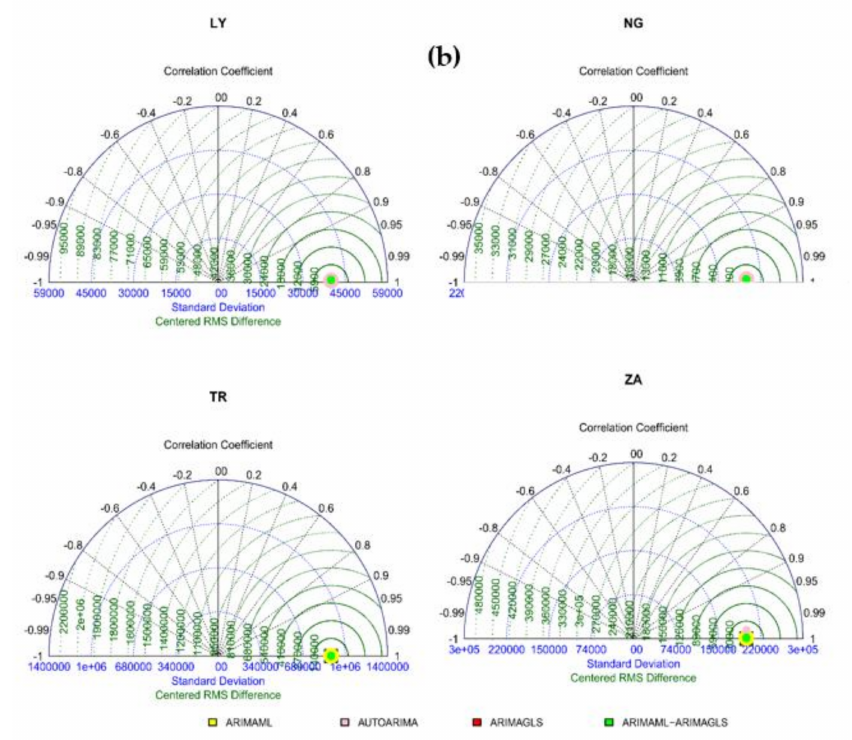
Figure 12. Taylor diagram for the: ( a ) training, and ( b ) testing samples.